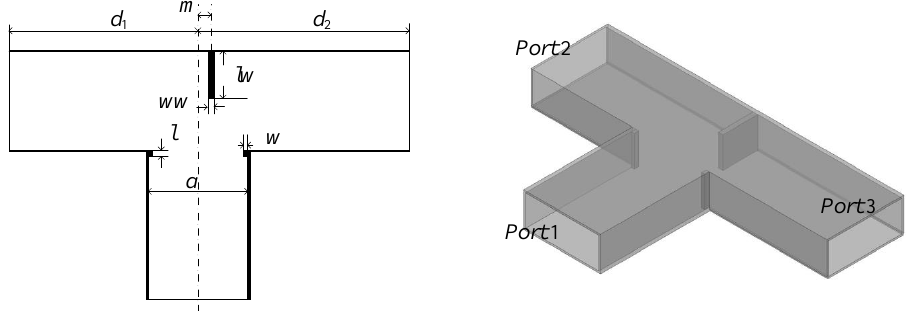
Figure 6. Unequal T-junction power divider ( a = 8.6mm, m = 0.97mm, l = 0.52mm, w = 0.36mm, lw = 4.08mm, ww = 0.54mm, d 1 = 17.14mm and d 2 = 17.46mm).